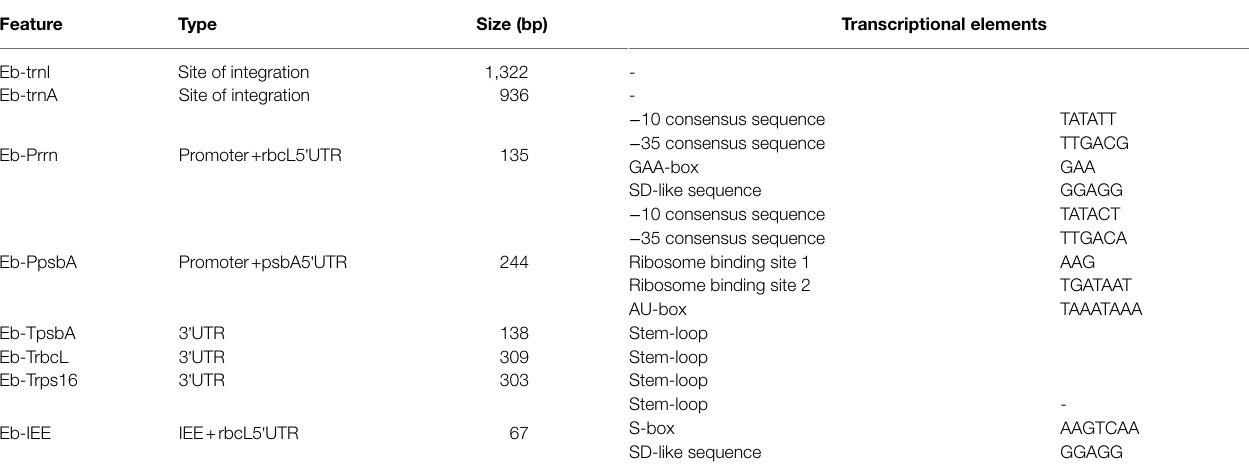
TABLE 4 | Regulatory elements of E. breviscapus cp